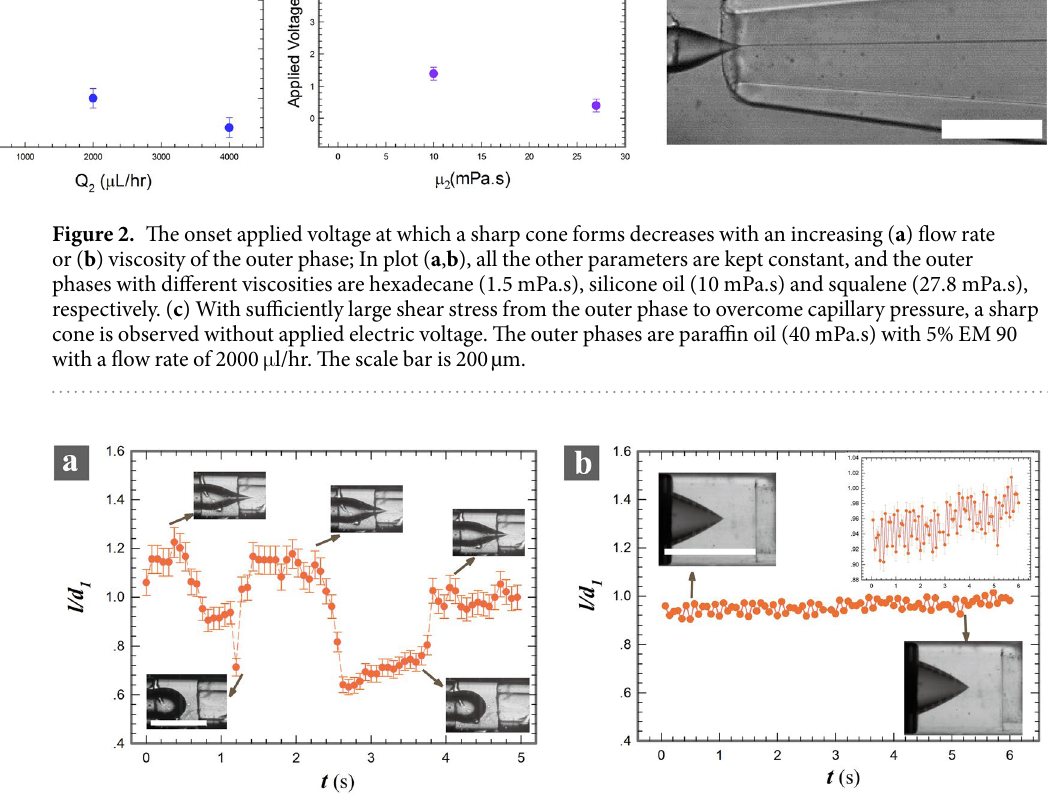
Figure 3. A plot of the normalized length of the water tip against time under a constant applied voltage U = 11 kV at different flow rates: ( a ) Q 1 = 5 μ l/hr and Q 2 = 6000 μ l/hr; ( b ) Q 1 = 60 μ l/hr and Q 2 = 6000 μ l/hr. The analyzed images are extracted every 30 frames from a high-speed video recorded at 400 fps. Scale bars are 1 mm. (Inset: close-up of the plot ( b